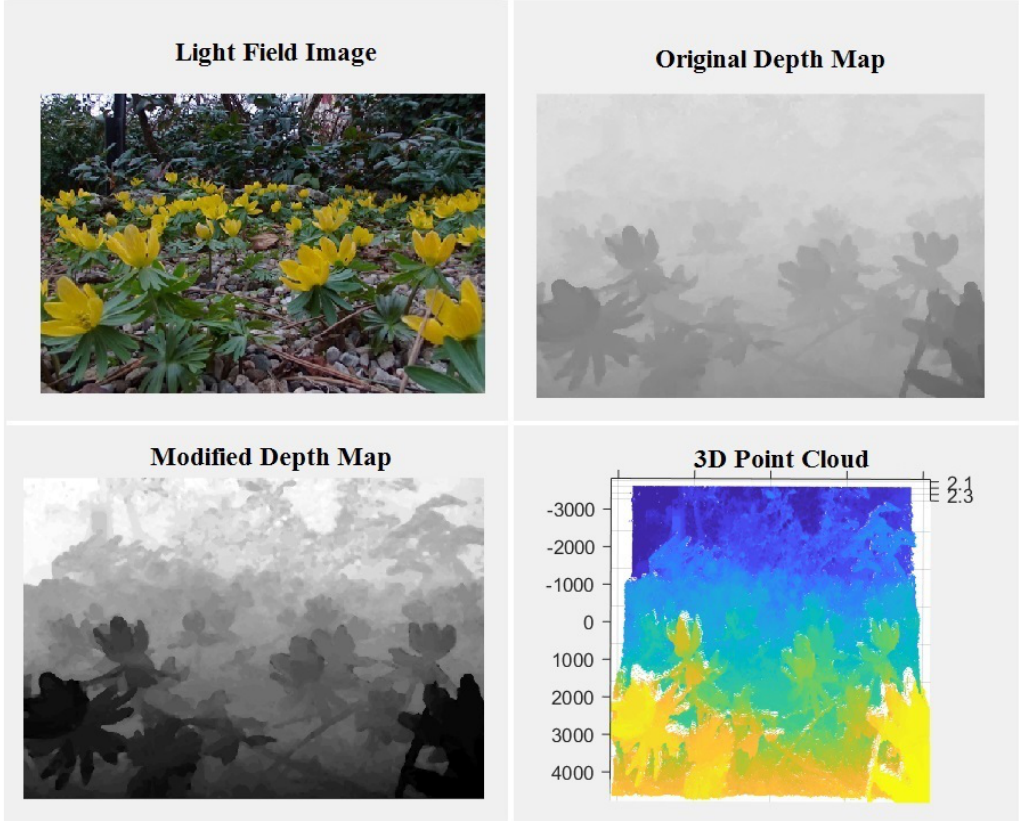
Figure 6. Obtaining a 3D point cloud based on the JPEG real world light field image (Nature- Flowers).